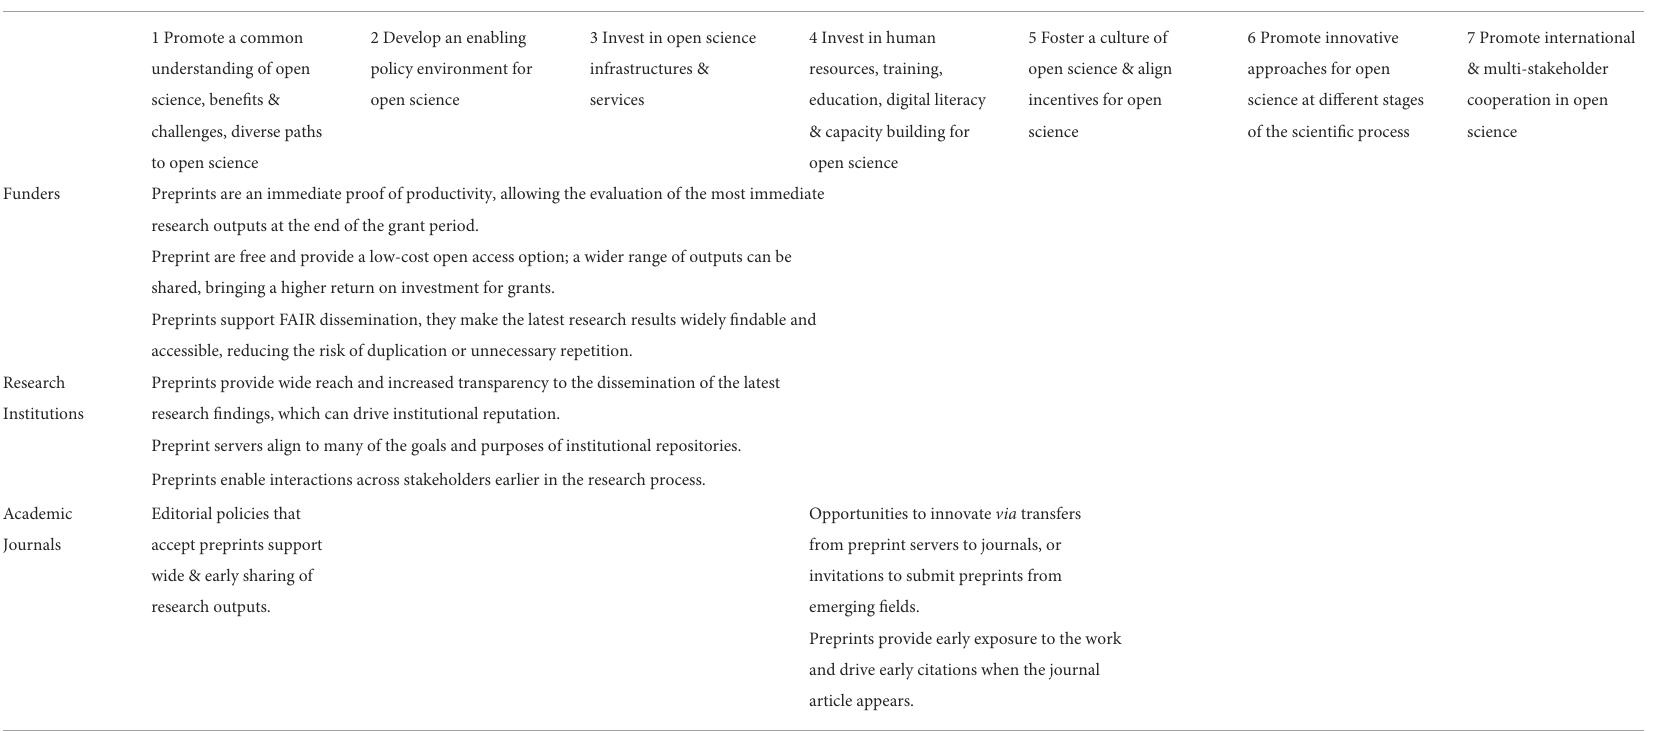
TABLE 2 Benefits of preprints to the different stakeholders involved in research.